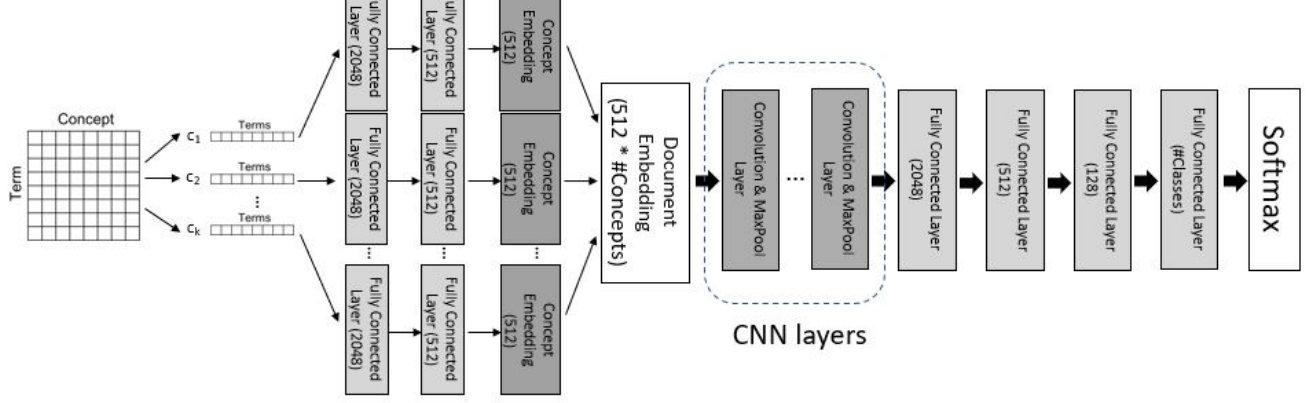
Figure 9. TSM-based deep neural network III: Concept-wise